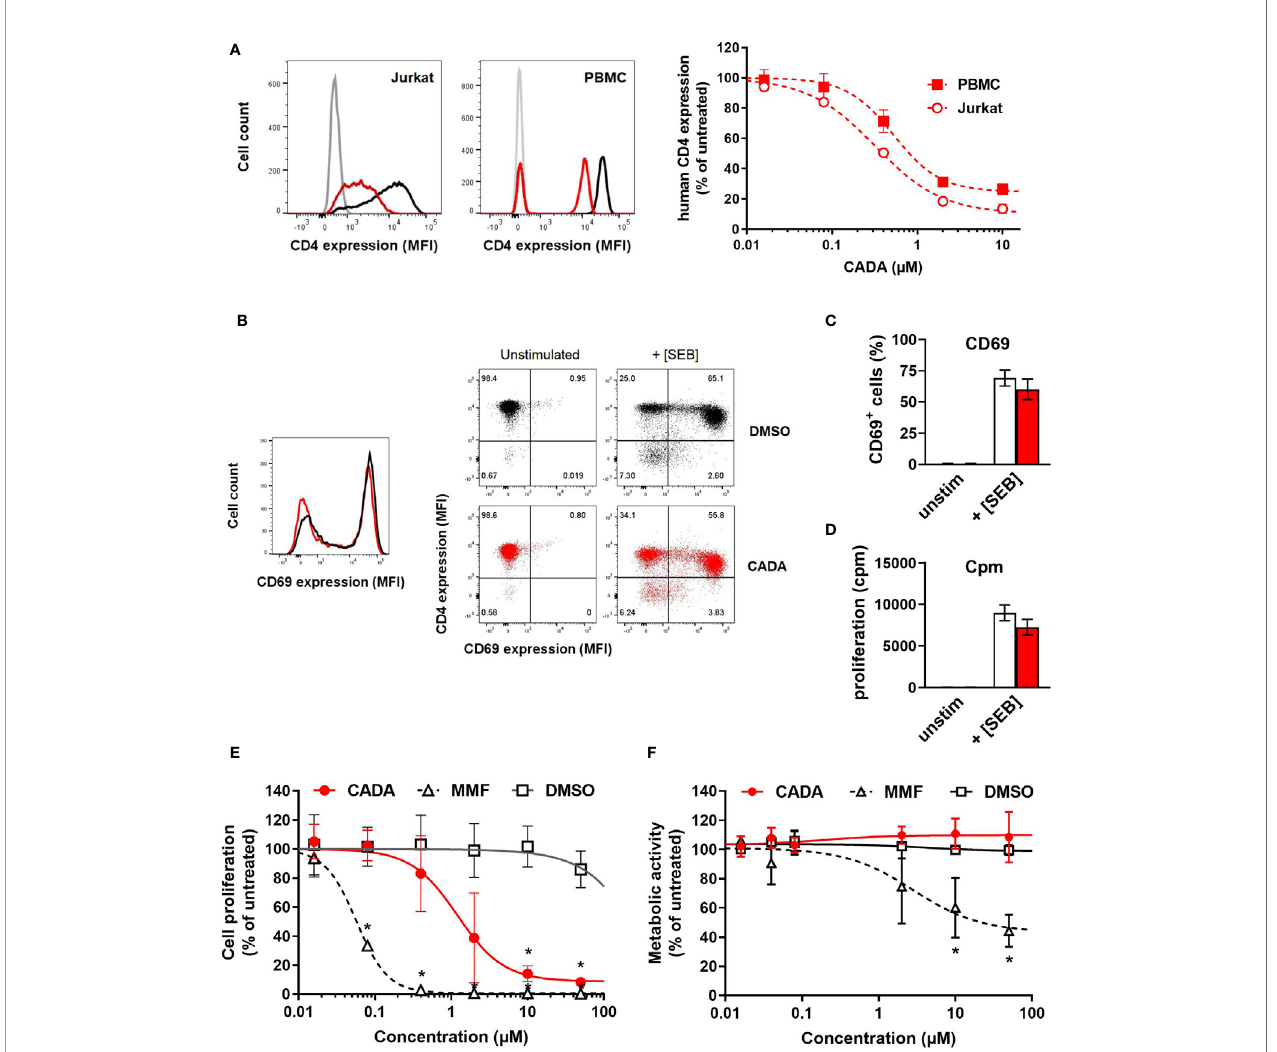
FIGURE 1 | CADA down-modulates the human CD4 receptor and has an immunosuppressive effect in the mixed lymphocyte reaction. (A) Representative fl ow cytometry histogram plots are given for cell surface human CD4 in Jurkat cells and PBMCs treated with DMSO or CADA (2 µM). Control cells are depicted in black, CADA-treated cells in red, and unstained controls in grey. Cells were incubated with CADA and CD4 expression was measured using a PE-labeled anti-human CD4 antibody (clone SK3) after 2 days for Jurkat cells or 5 days for PBMCs. The graph shows relative CD4 expression in CADA-treated cells, based on the Mean Fluorescence Intensity (MFI) values for CD4 (acquired from at least 10,000 cells per experiment) and calculated as percentage of untreated control (mean ± SD). Four parameter dose-response curves are given for CADA, calculated from 3 independent experiments (n=3). (B) Naive CD4 + T cells were pre-treated with CADA (10 m M) for 3 days and subsequently stimulated with mitomycin C inactivated Raji-GFP cells loaded with staphylococcal enterotoxin B (SEB). CD69 and CD4 expression was measured 24h later. Histogram plot represents the CD69 expression of naive CD4 + T cells, with control cells indicated in black and CADA-treated cells in red. Dot plots from a representative donor show CD4 and CD69 double staining on unstimulated and stimulated cells at 24h post activation. (C) Same as in (B) , but the CD69 positive cells were quanti fi ed and calculated as percentage of total cell population. Bar diagrams are showing the amount of CD69 positive cells on day 1 post activation with DMSO in white and CADA in red. Values represent mean ± SD of four different donors (n=4). (D) Naive CD4 + T cells were pre-treated with CADA (10 m M) for 3 days and subsequently stimulated with mitomycin C inactivated Raji-GFP cells loaded with SEB. At day 2 post activation, [ 3 H]-thymidine was added and proliferation response was measured by detecting cpm 18h later. Bar diagrams are showing cpm values with DMSO in white and CADA in red. Values represent mean ± SD of two different donors (n=2). (E) PBMCs were co-cultured with mitomycin C inactivated RPMI1788 cells in the presence of CADA, MMF or matching DMSO concentrations. At day 5, [ 3 H]-thymidine was added and proliferation response was measured 18h later by detecting counts per minute. Lymphocyte proliferation is given as percentage of untreated control. Multiple t-tests were performed to compare each concentration of CADA or MMF to the corresponding DMSO control with *p<0.05 and with Holm-Sidak method as correction for multiple comparison. Curves are showing mean values ± SD of four different donors (n=4). (F) PBMCs were stimulated with PHA for 3 days and were subsequently exposed to different concentrations of CADA, MMF or DMSO. After 2 days of drug treatment, MTS-PES was added to measure cellular metabolic activity, and read-out was done 24h later on a spectrophotometer. Metabolic activity of cells is given as percentage of untreated control. Multiple t-tests were performed to compare each concentration of CADA or MMF to the corresponding DMSO control with *p<0.05 and with Holm-Sidak method as correction for multiple comparison. Curves are showing mean values ± SD of four different donors (n=4). (E) See also Supplementary Figures 1 and 2